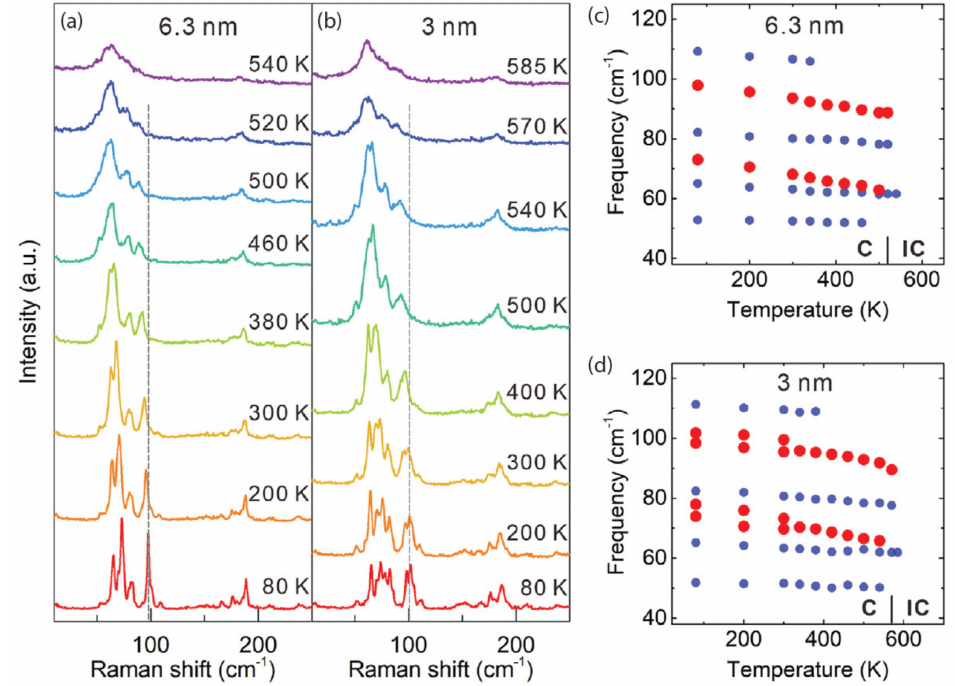
Figure 15. Raman spectroscopic investigation of the CDW transition in 6.3 nm– and 3 nm–thick 1 T -TaSe 2 . Raman spectra are shown for ( a ) 6.3 nm and ( b ) 3 nm 1 T -TaSe 2 at selected temperatures for the heating cycle. The temperature dependence of the phonon frequencies is shown for the ( c ) 6.3 nm and ( d ) 3 nm 1 T -TaSe 2 . Soft modes are indicated with red dots. Reprinted figure with permission from Reference [149]. Copyright 2020 by John Wiley and Sons,